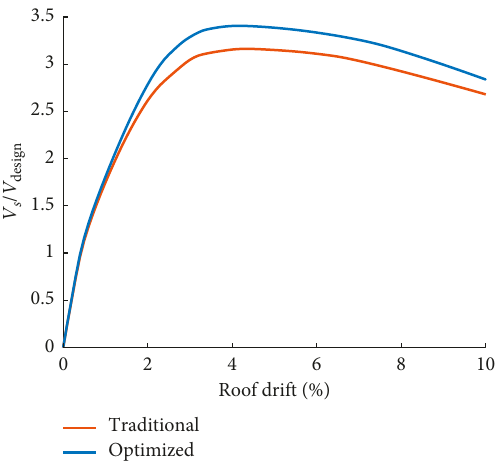
Figure 3: Pushover results for the four-story buildings.